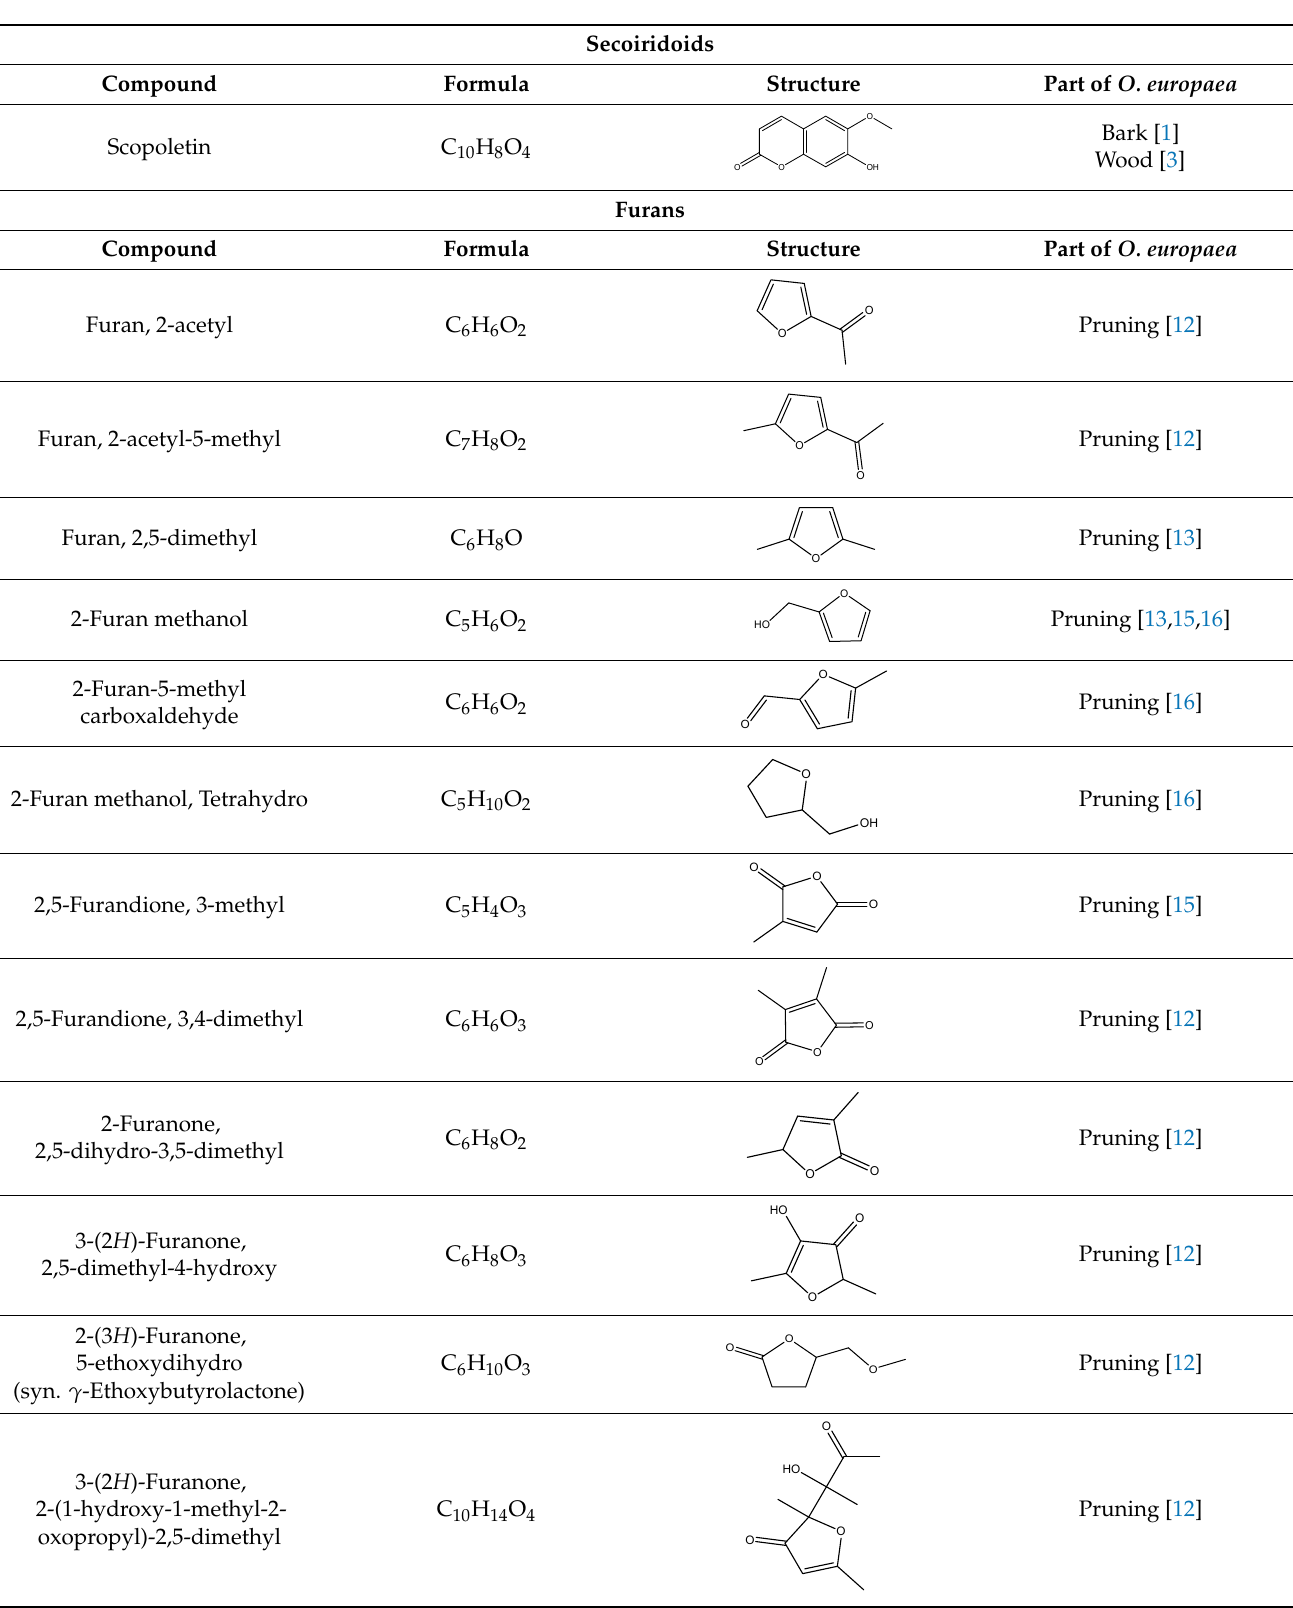
Table 1. Cont. Secoiridoids Formula Structure Part of O. europaea